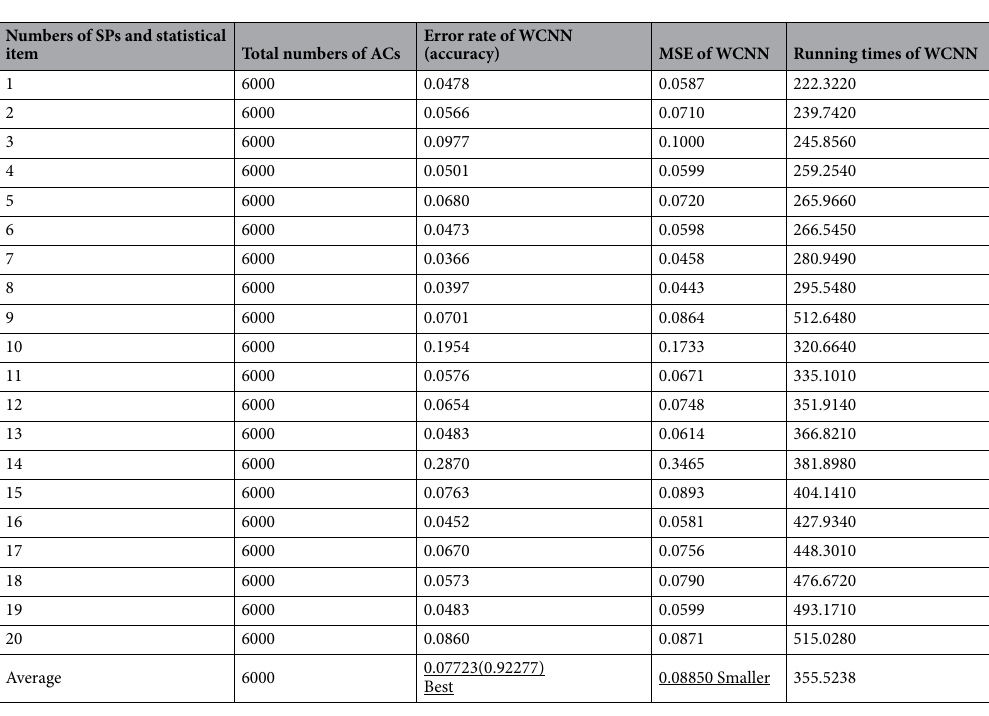
Table 5. Simulation results of WCNN on MNIST. Underlined values represent the results with the highest accuracy or the lowest mean square error.